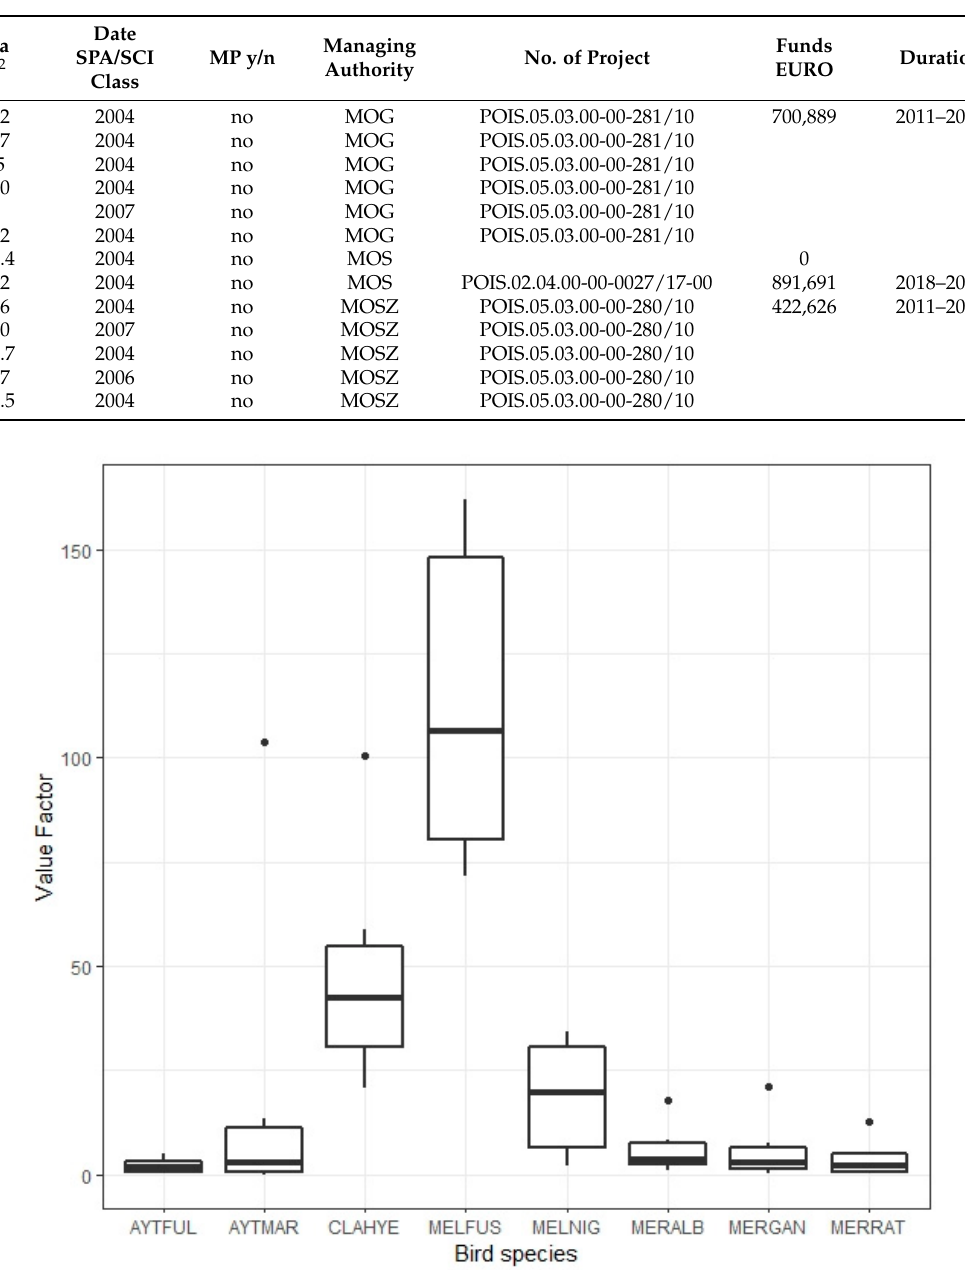
Figure 3. Value factors (VFs) for the most numerous waterbird species present during the non- breeding period in Polish seawaters. Horizontal thick line—mean, dots—outliers. Species ab- breviations: MELFUS—Velvet Scoter, CLAHYE—Long-tailed Duck, AYTMAR—Greater